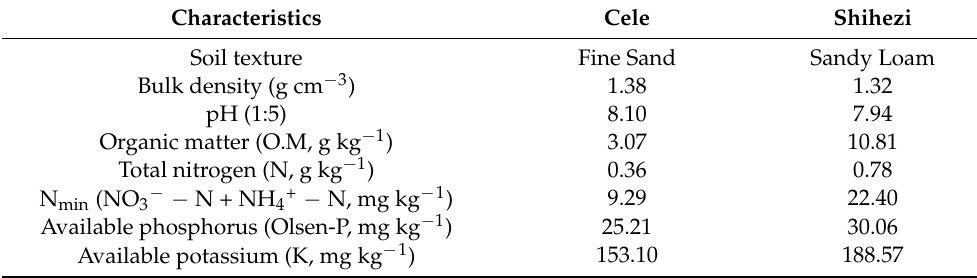
Table 1. Physical and chemical properties of the 0–30 cm soil layer of the experimental sites in Xinjiang.